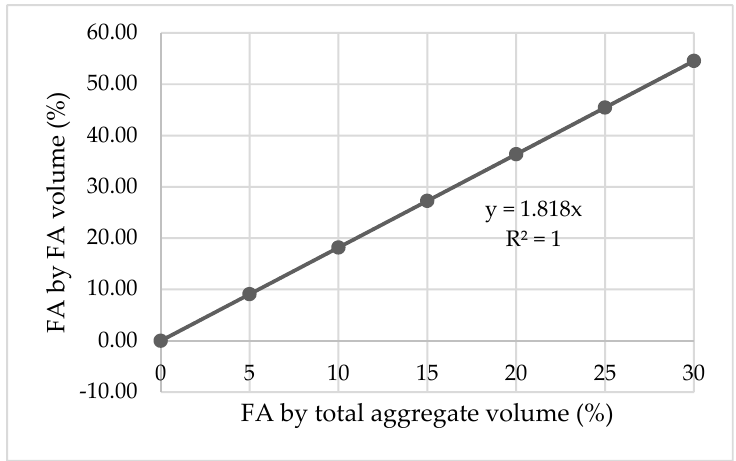
FA by total aggregate volume (%) Figure 18. Conversion coe ffi cient (c = 1 / 1.818 = 0.55). Figure 18. Conversion coefficient (c = 1/1.818 = 0.55).